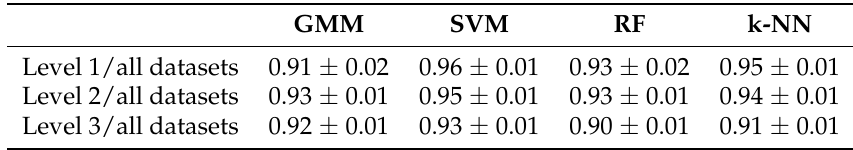
Table 3. Accuracy comparison between the classifiers based on the average kappa values ± standard deviation computed from the results of all the nine datasets.